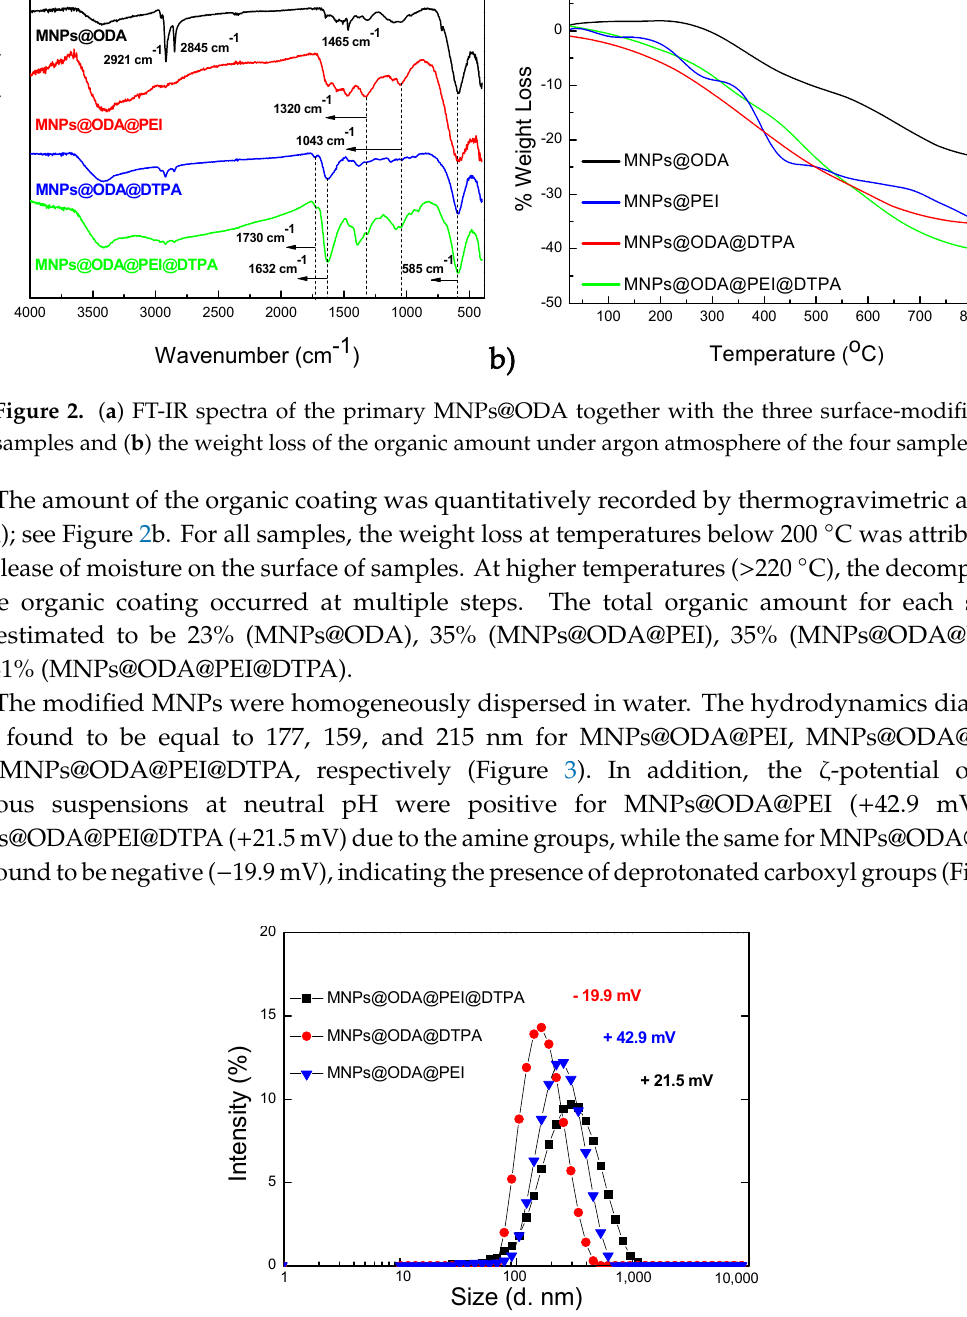
Figure 3. Hydrodynamics diameters and ζ -potentials of the three surface-modified samples.